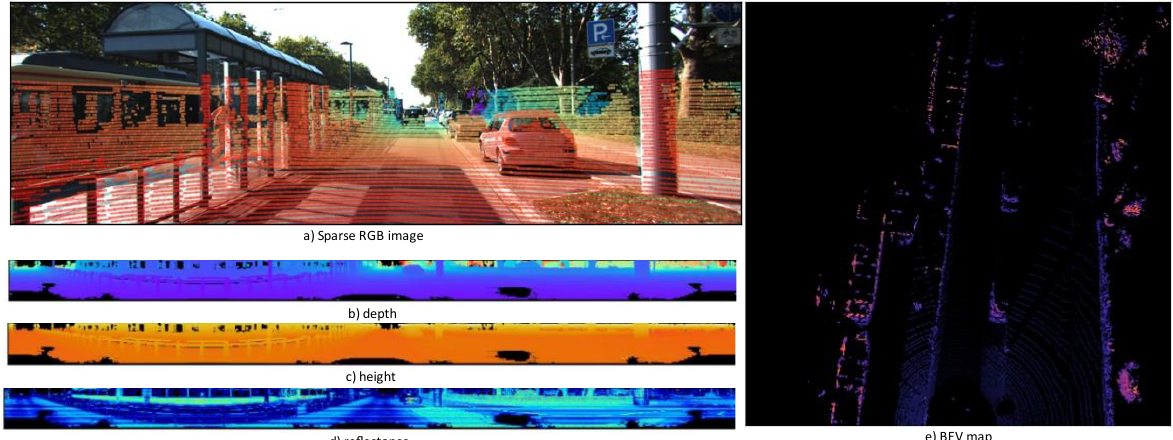
Figure 2. Multiview representation of a 3D point cloud projected into RGB images.